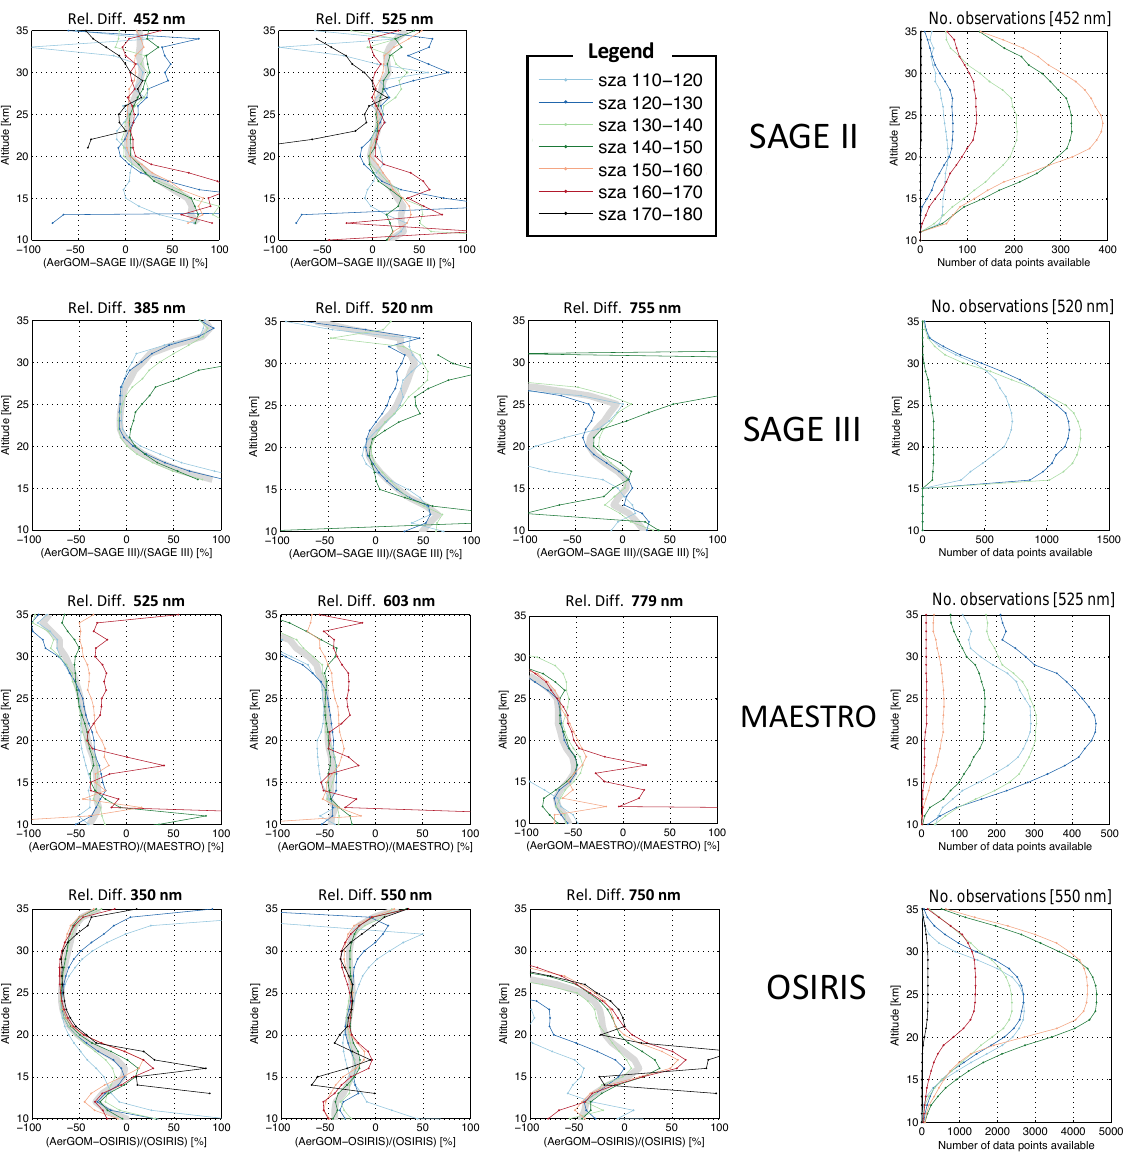
Figure 8. Relative differences between AerGOM and SAGE II, SAGE III, MAESTRO and OSIRIS datasets for different categories of SZA, ranging from 110 to 180 in 10 ◦ increments (left panels). The rightmost panel presents the number of observations for each comparison and SZA